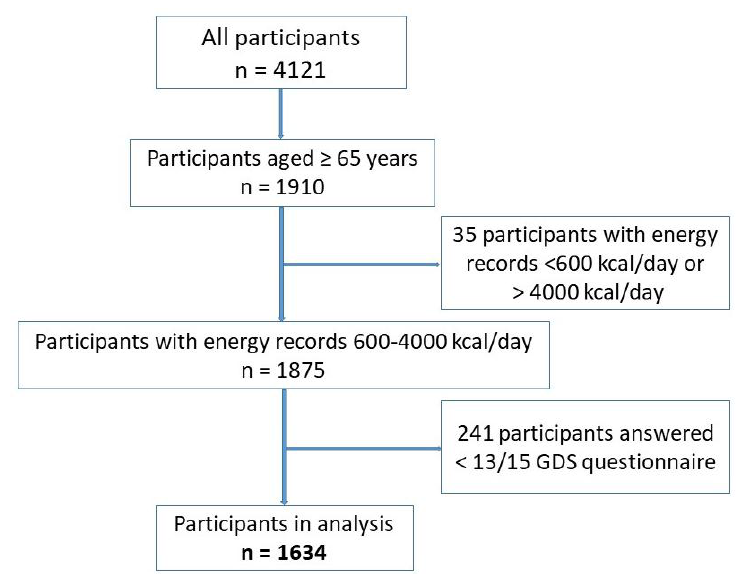
Figure 1. Participant recruitment chart.